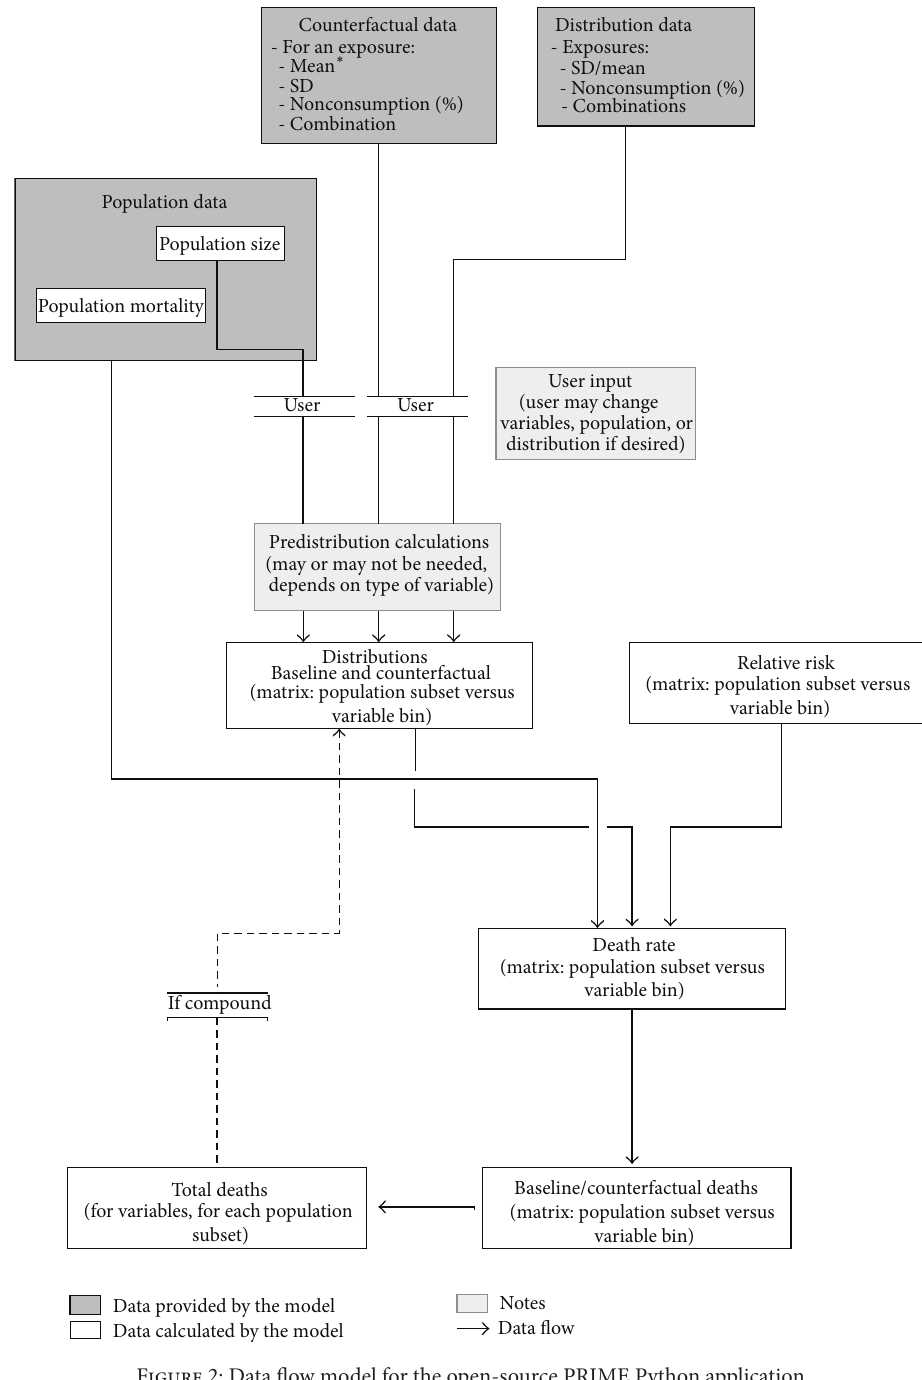
Figure 2: Data flow model for the open-source PRIME Python